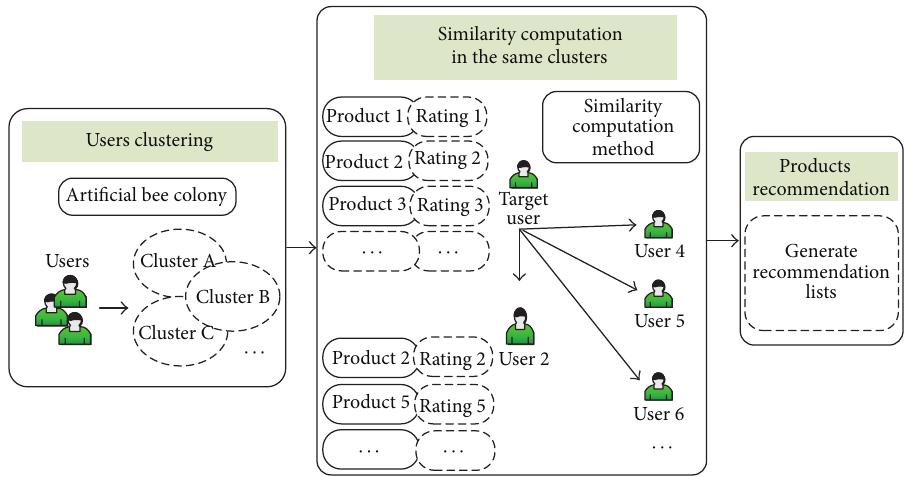
Figure 1: The framework of recommendation model based on users